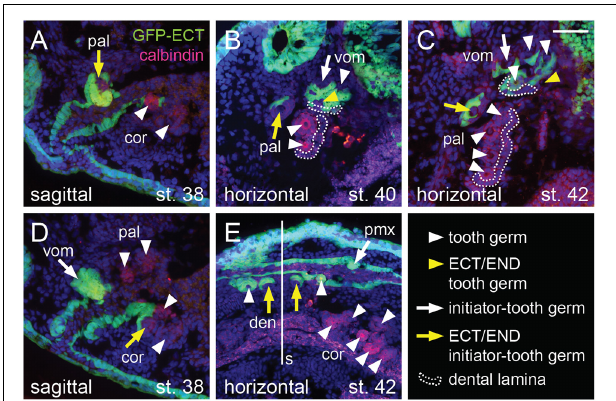
FIGURE 6 | Histological analysis of the epithelial origin of the axolotl teeth. Histological analysis shows details of epithelial origin and modes of addition of teeth (marked by anti-calbindin antibody) within the tooth fields. Arrows mark initiator-tooth germs in each tooth field, arrowheads mark sequentially added tooth germs, yellow arrow/arrowhead denotes tooth developing at the ecto-endoderm boundary, and white arrow/arrowhead denotes tooth developing solely from either ectodermal or endodermal epithelium. (A) Sagittal section showing lateral-most palatine tooth developing at the ecto-endoderm boundary (yellow arrow) close to endoderm-derived coronoid tooth germs (white arrowheads). (B) Horizontal section through vomerine and palatine tooth fields. Two vomerine teeth develop in the ectodermal epithelium (white arrow and arrowhead) and one tooth germ is of ecto-endodermal origin (yellow arrowhead). Palatine tooth field is composed of one ecto-endodermal tooth germ labially (yellow arrow) and two endodermal germs (white arrowheads) lingually. Note the just-arising successional dental laminae (broken lines) that are of endodermal origin in case of the palatine field and ecto-endodermal origin in case of the vomerine field. (C) Horizontal section of later stage vomerine and palatine tooth fields showing ecto-endodermal germ in each vomerine and palatine fields (yellow arrow and arrowhead) next to other ectodermal vomerine teeth and endodermal palatine teeth (white arrowheads). Successional dental laminae (broken lines) are of ecto-endodermal origin in vomerine field and endodermal origin in palatine field. (D) Sagittal section medial to that shown in (A) depicting ecto-endodermal coronoid tooth (yellow arrow), which develops at the level of other tooth germs of vomerine, palatine, and coronoid tooth fields (white arrow and arrowheads). (E) Horizontal section showing ecto-endodermal teeth developing medially in the dentary tooth field (yellow arrows) next to other ectodermal teeth of dentary and premaxillary fields and endodermal teeth of the coronoid field (white arrowheads). den, dentary teeth; pal, palatine teeth; pmx, premaxillary teeth; cor, coronoid teeth; s, symphysis; vom, vomerine teeth. Scale bar equals 50 µ